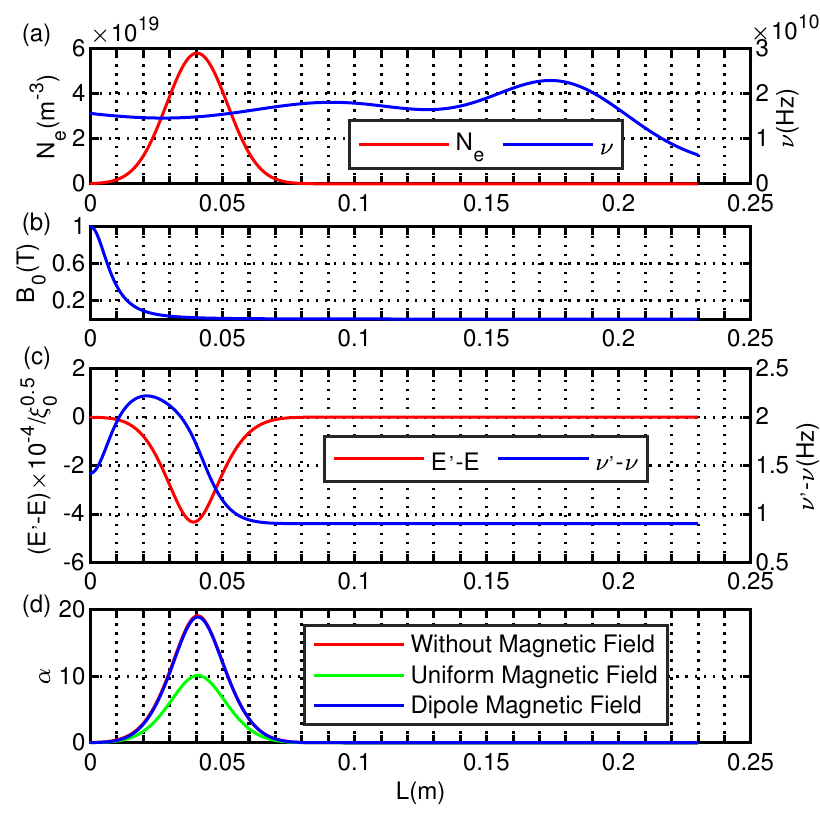
Figure 2. Parameter distributions in the plasma sheath. ( a ) N e and υ , ( b ) B 0 , ( c ) E (cid:48) − E and υ (cid:48) − υ , ( d ) α